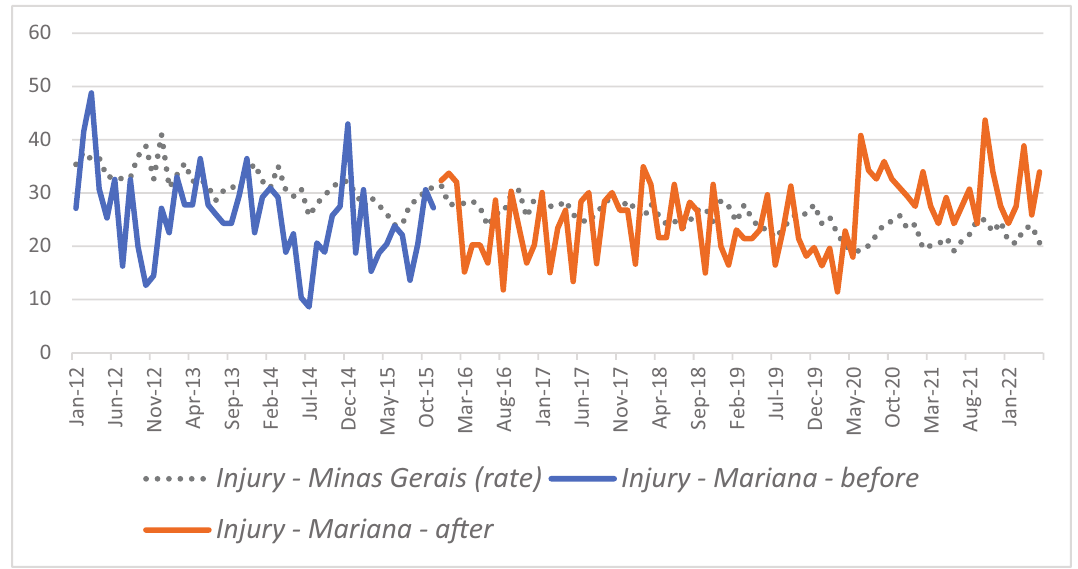
Injury - Mariana - before Injury - Mariana - a(cid:31)er Figure 8. Rate of injuries per month, for Minas Gerais and Mariana – 2012- 2022 Source: Occurrences: Armazém Sisp (official data warehouse for Minas Gerais state public security system). Demographic data: